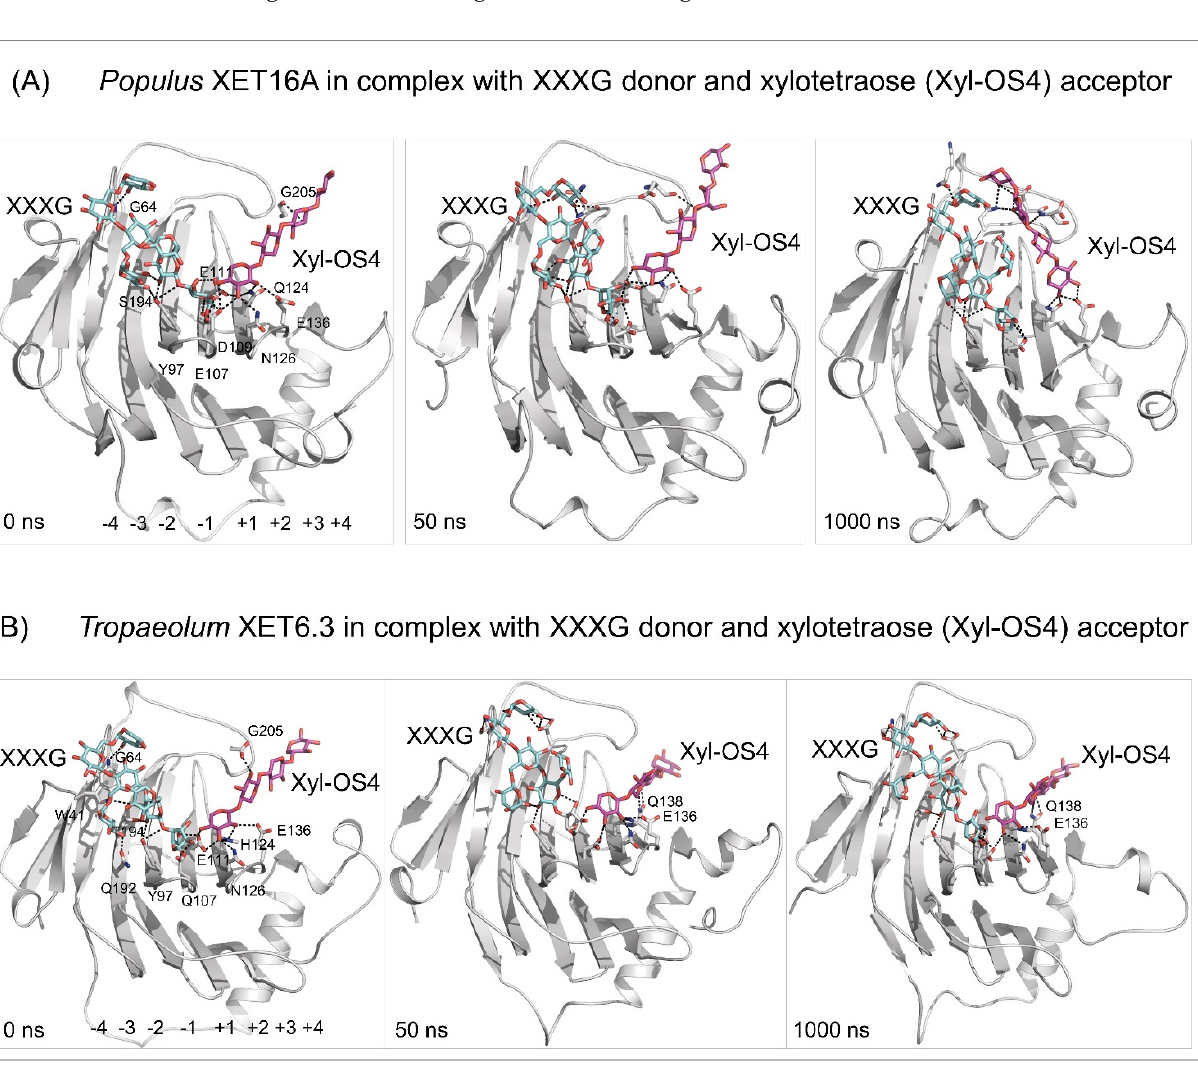
cpk sticks and emphasised in dots. Subsites at -4 to -1 for XXXG and +1 to +5 for [ α (1-4)GalA p ] 5 are indicated. Images were generated in PyMOL as referenced in Figure 2. Bottom panel : Some of the residues of Hordeum XETs that bind [ α (1-4)GalA p ] 5 (highlighted in yellow) are shown in the align- ment by PROMALS3D [83] of the Hordeum XET sequences (numbering includes signal peptides).